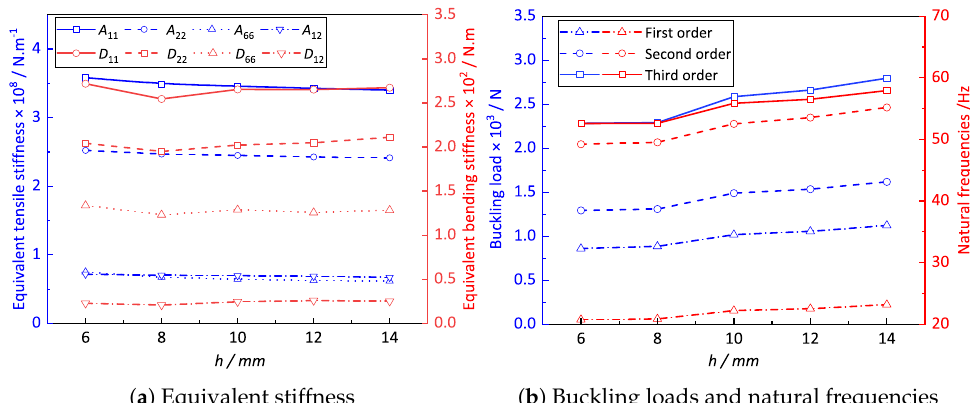
( b ) Buckling loads and natural frequencies Figure 11. The influence of h on the effective performance of CCCP. Figure 12a shows the influence of thickness t on the equivalent stiffness of CCCP. It can be seen that the equivalent tensile stiffness of CCCP increases linearly with the increasing thickness t , while the equivalent bending stiffness increases nonlinearly, which has a great influence on the buckling load and natural frequency of CCCP as shown in Figure 12b. The reason is that with the plate thickness t increases, the orthogonality of CCCP becomes